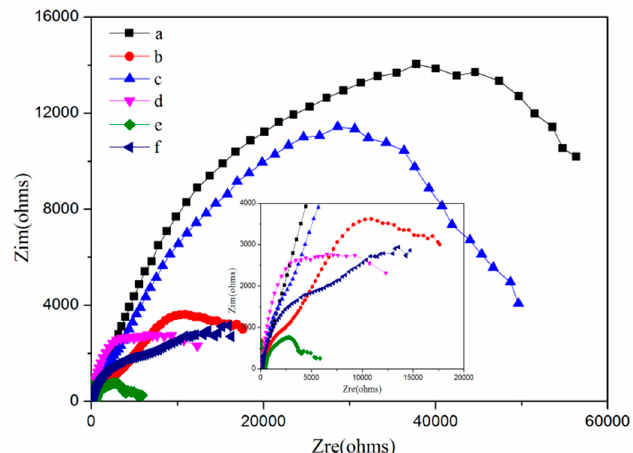
Figure 11. Nyquist plots of the TO / TMMP-TMTGE self-healing coating material ( a ) in the original state, and after ( b ) scratching and ( c ) healing, and the TMMP-TMTGE self-healing coating material ( d ) in original state and after ( e ) scratching and ( f ) healing.